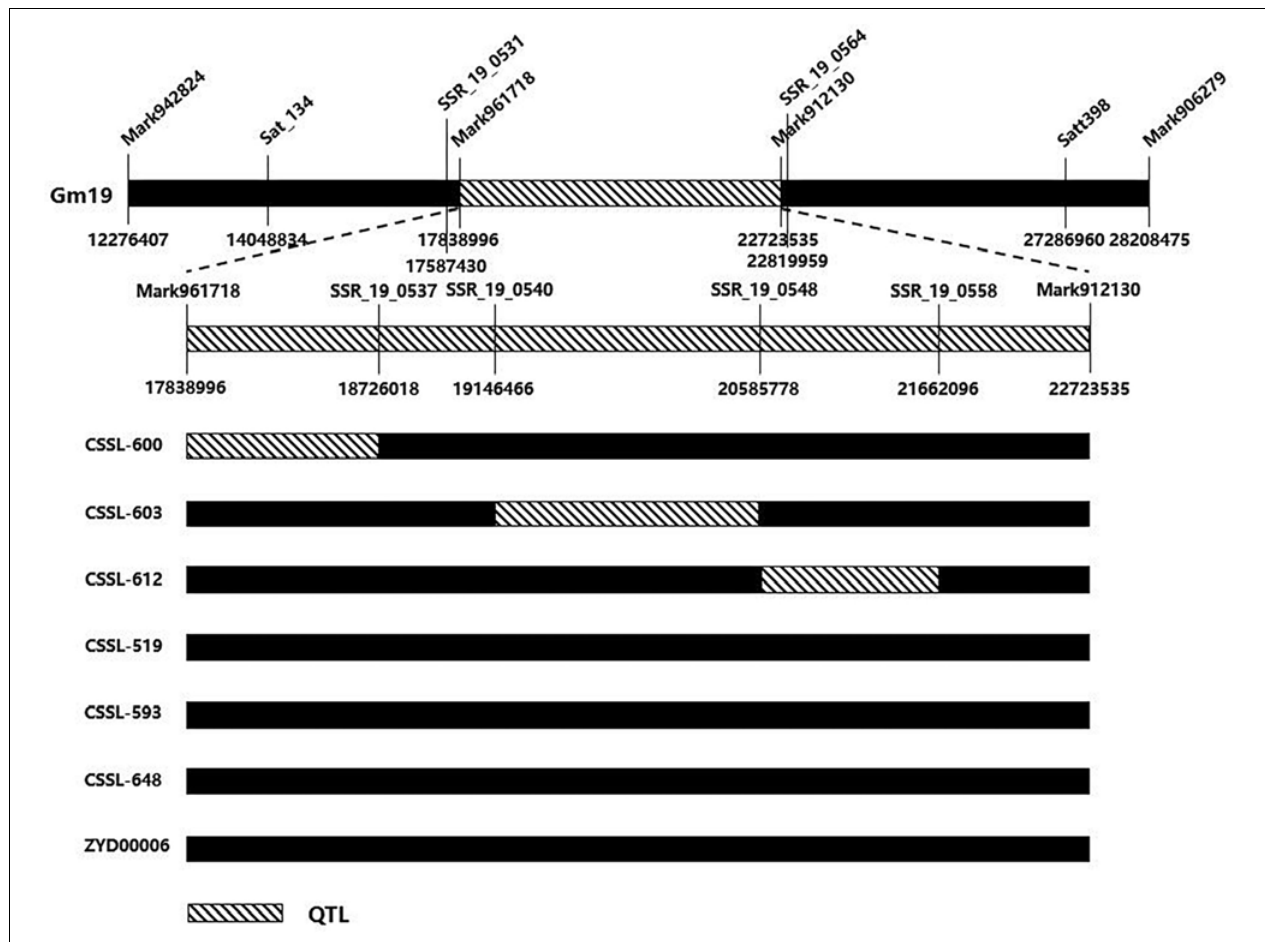
FIGURE 4 | Validation of consensus quantitative trait locus (QTL) in chromosome segment substitution lines (CSSLs). The consensus QTL associated with nodulation phenotype on chromosome Gm19 (97.5–133.2 cM) had a corresponding partial region in the substituted wild soybean chromosomal segment on Gm19 in CSSL-600, CSSL-603, and CSSL-612. On the contrary, there was no corresponding region in CSSL-519, CSSL-593, CSSL-648, or